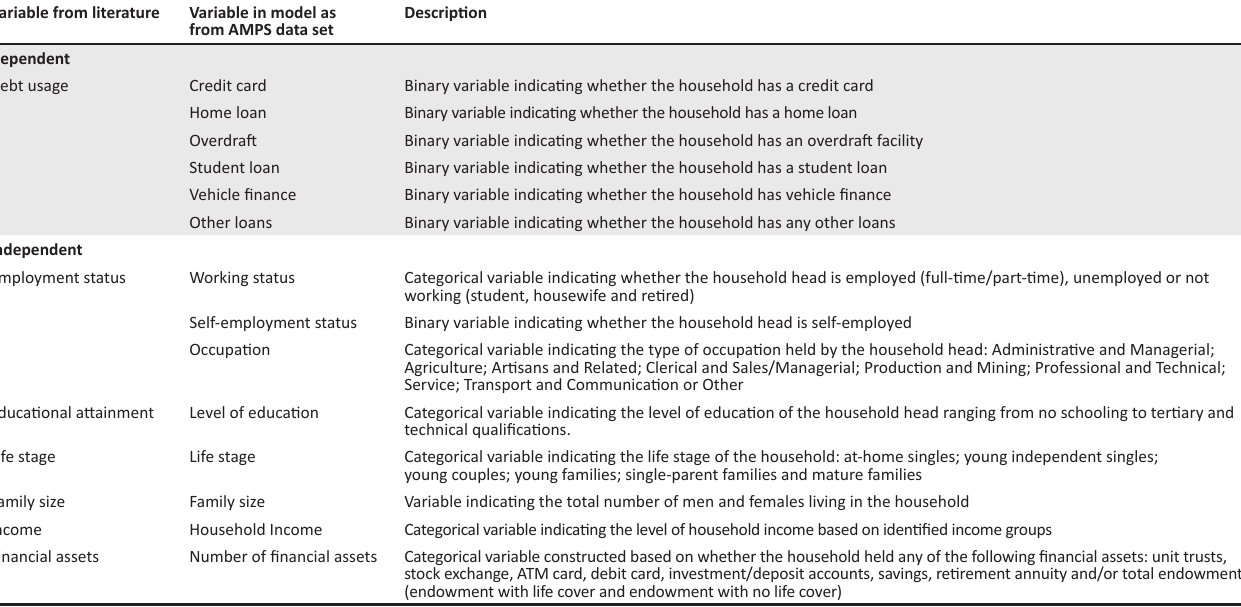
TABLE 2: Variable descriptions. Variable from